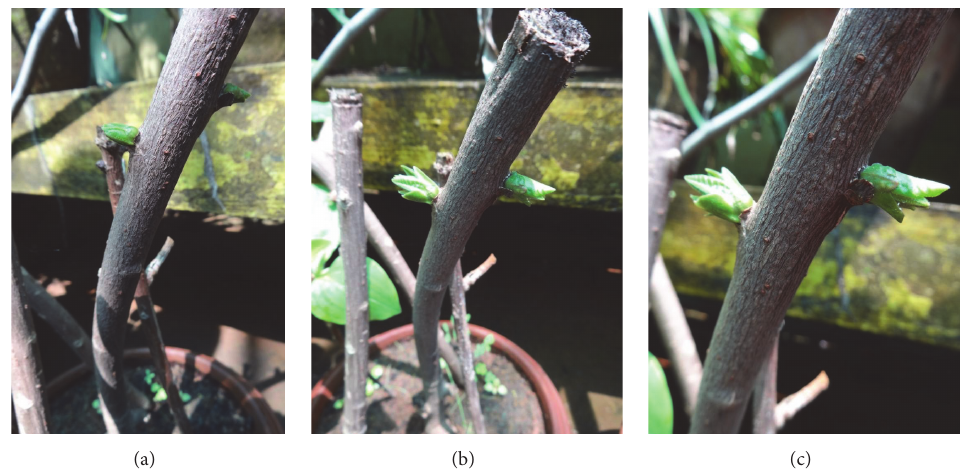
Figure 2: (a)–(c) NAA pretreated cuttings after 6 weeks.